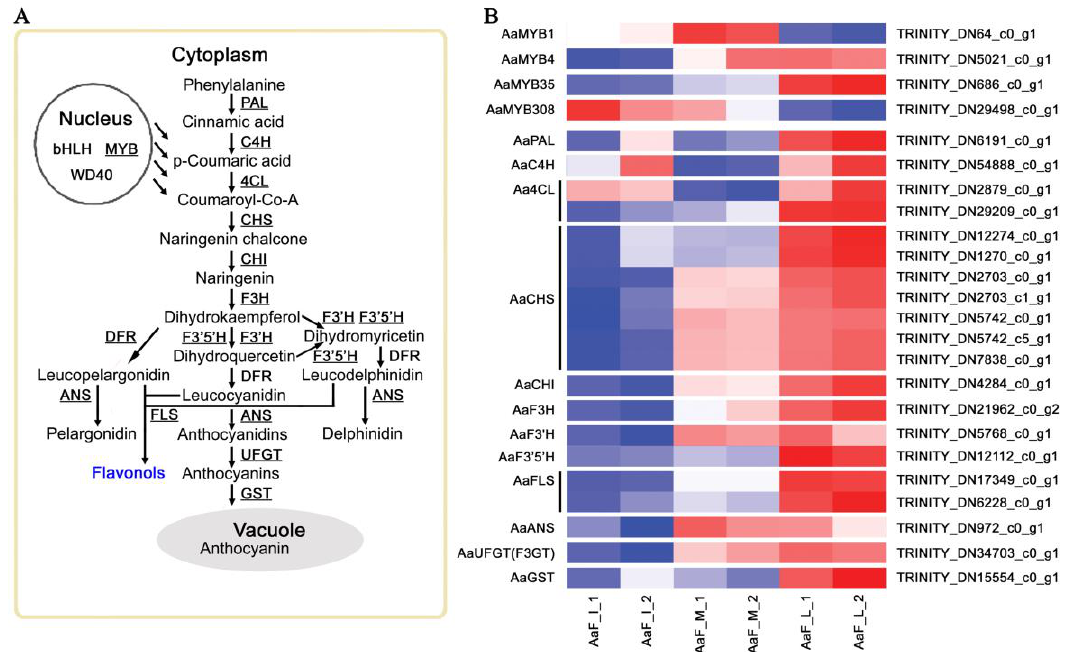
Figure 4. Expression patterns of the DEGs involved in anthocyanin biosynthesis at three developmental stages. ( A ), Schematic diagram of the anthocyanin biosynthetic pathway. DEGs are highlighted by underlines. ( B ), Heat maps of DEGs involved in anthocyanin biosynthesis at three developmental stages. Gene-expression level was measured using the TPM method. Horizontal axes represent three developmental stages, including initial stage (AaF_I_1 and AaF_I_2), middle stage (AaF_M_1 and AaF_M_2), last stage (AaF_L_1 and AaF_L_2), and vertical axes represent gene ID. Heat map shows the expression of genes ranging from blue (low expression) to red (high expression).